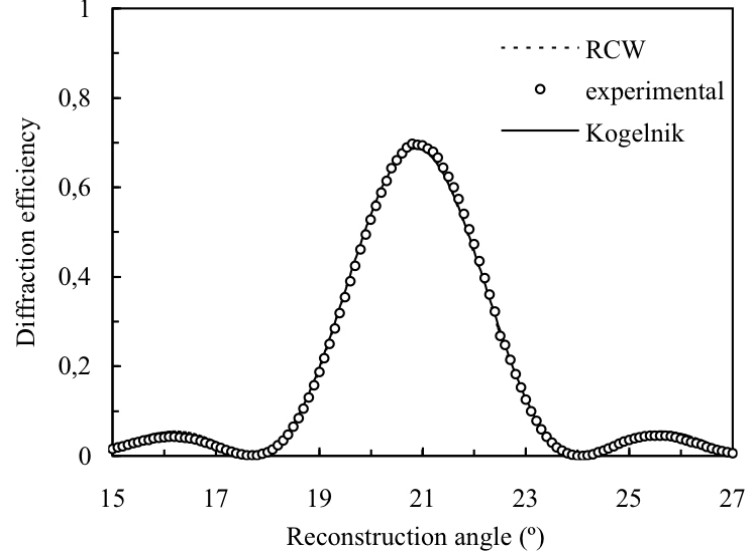
Figure 11. Diffraction efficiency of the order +1 for volume transmission gratings recorded in polyvinyl-alcohol/acrylamide (PVA/AA) with spatial frequency 1125 lines/mm and 23 µm of